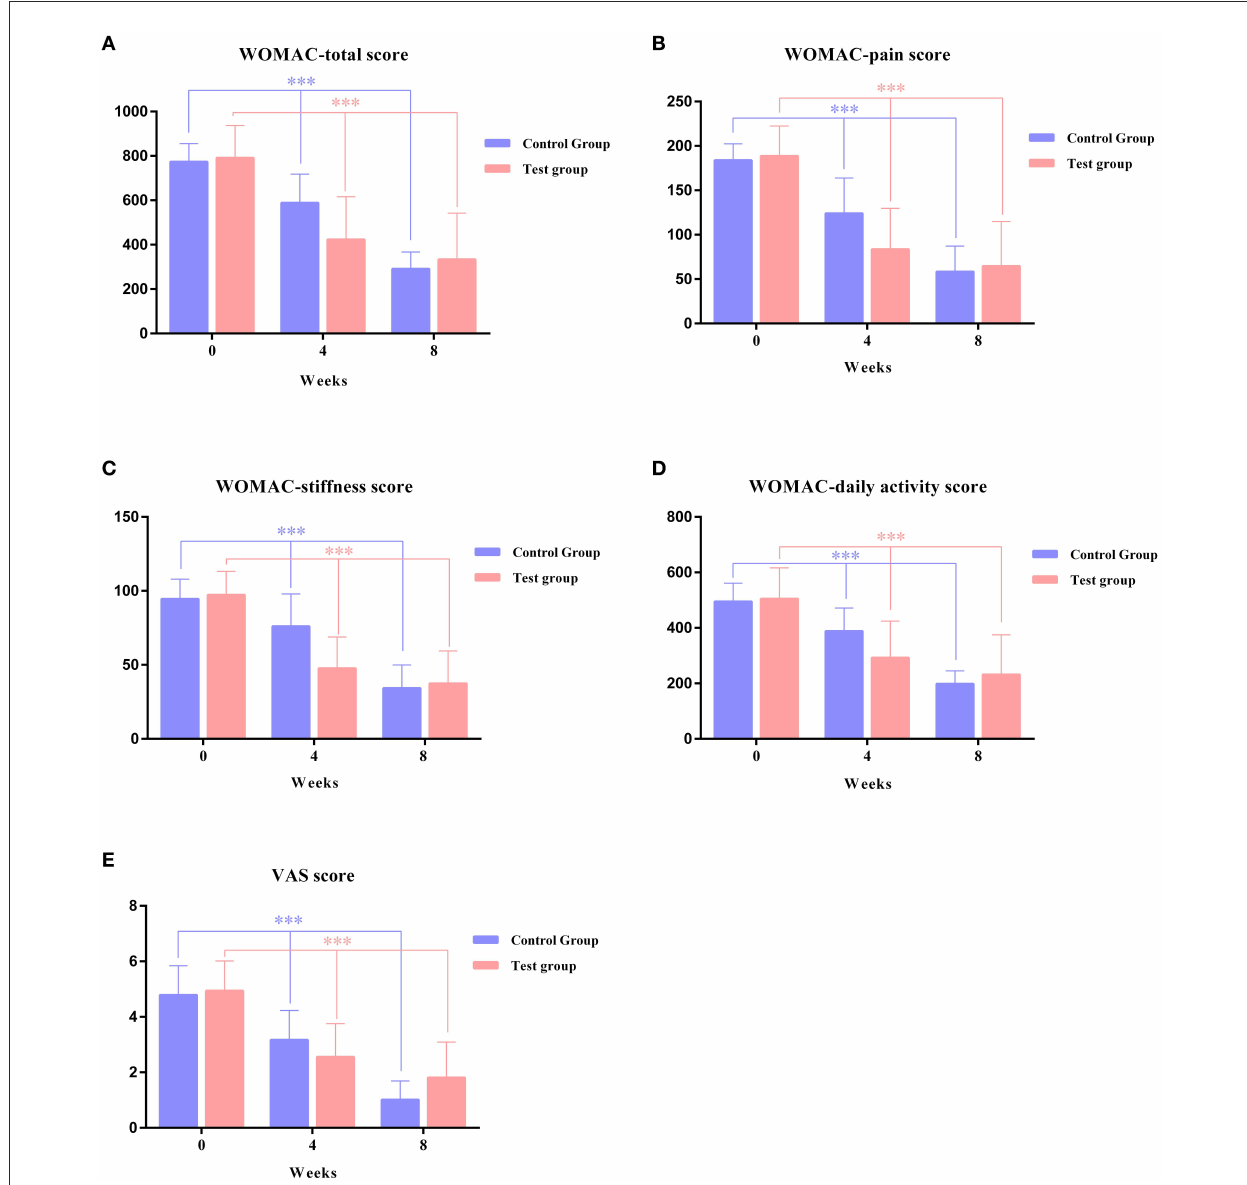
FIGURE3 Changes in primary outcomes over an 8-week study period between the test group and control group. (A) WOMAC total score, (B) WOMAC pain score, (C) WOMAC stiffness score, (D) WOMAC daily activity score, and (E) VAS score. ***Significant difference from 4-week group vs. baseline and 8-week group vs. 4